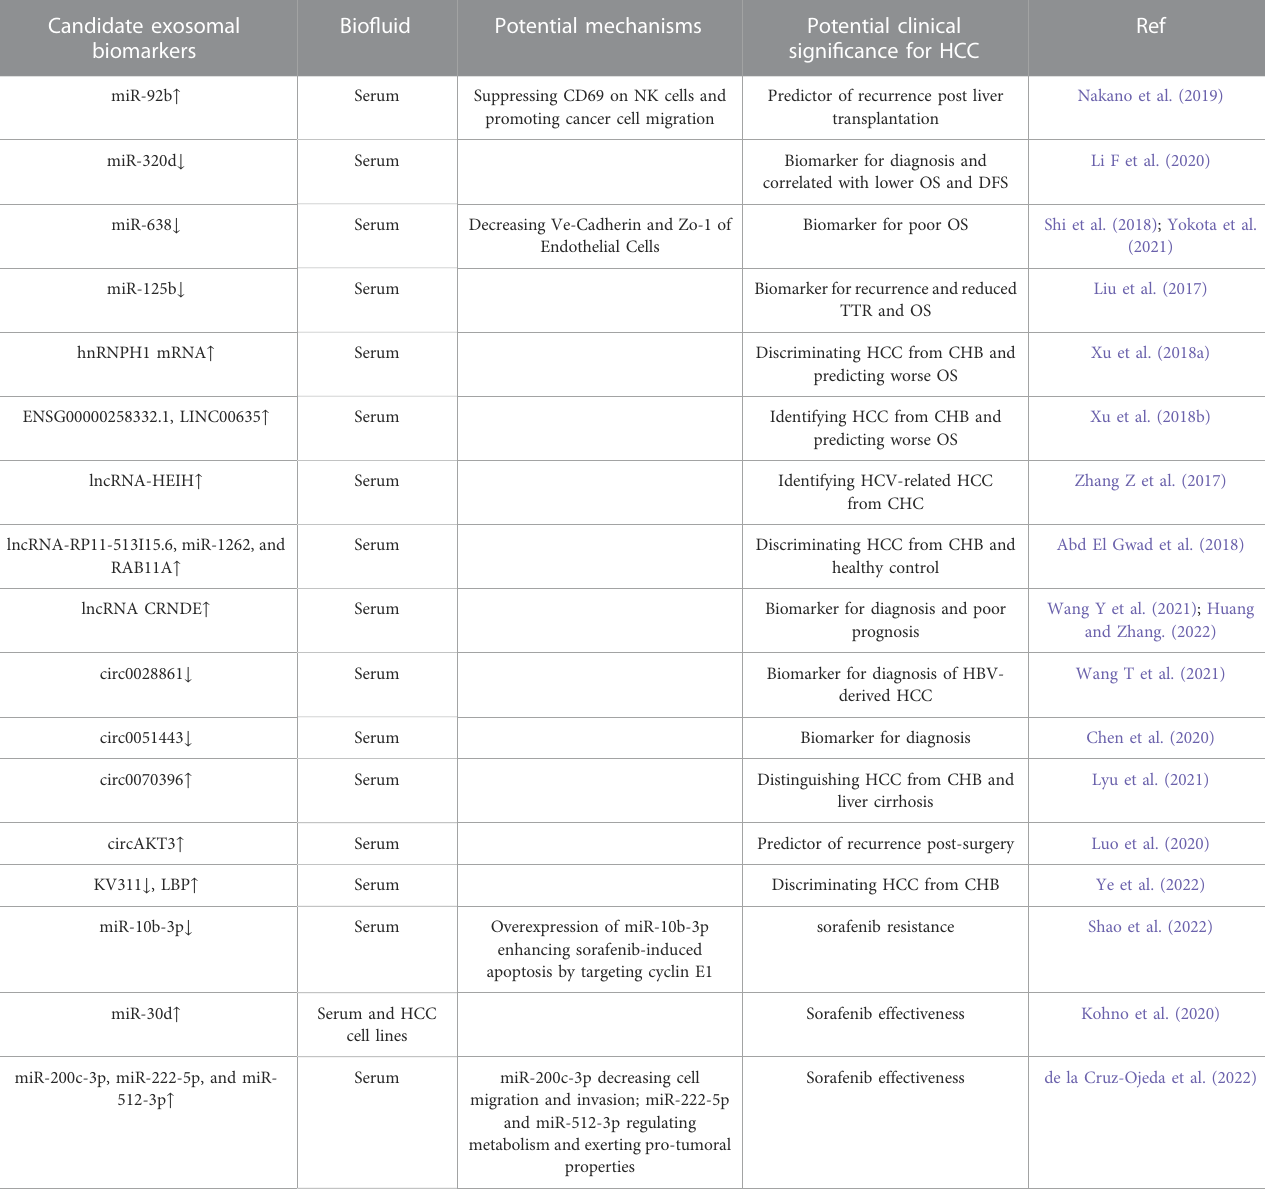
TABLE 1 ( Continued ) Potential exosomal biomarkers for HCC diagnosis, recurrence and